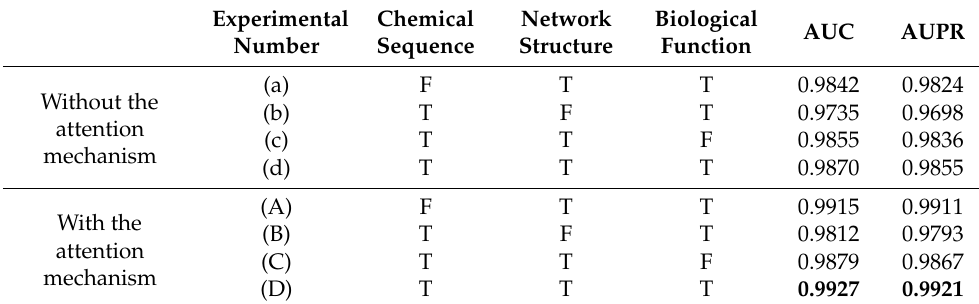
Table 3. Results of the ablation on